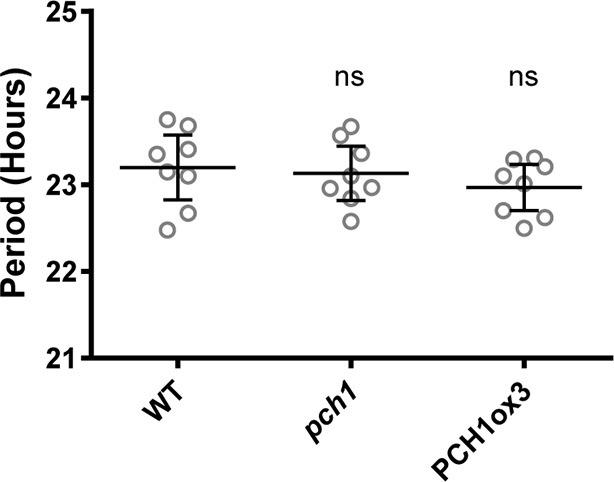
Modulating PCH1 levels does not affect the circadian period.Comparison of WT, pch1, and PCH1ox3 periods using data from Figure 3A and B. Mean ± 95% CI (n = 8). ns = not significantly different than WT. Experiments were repeated at least three times.